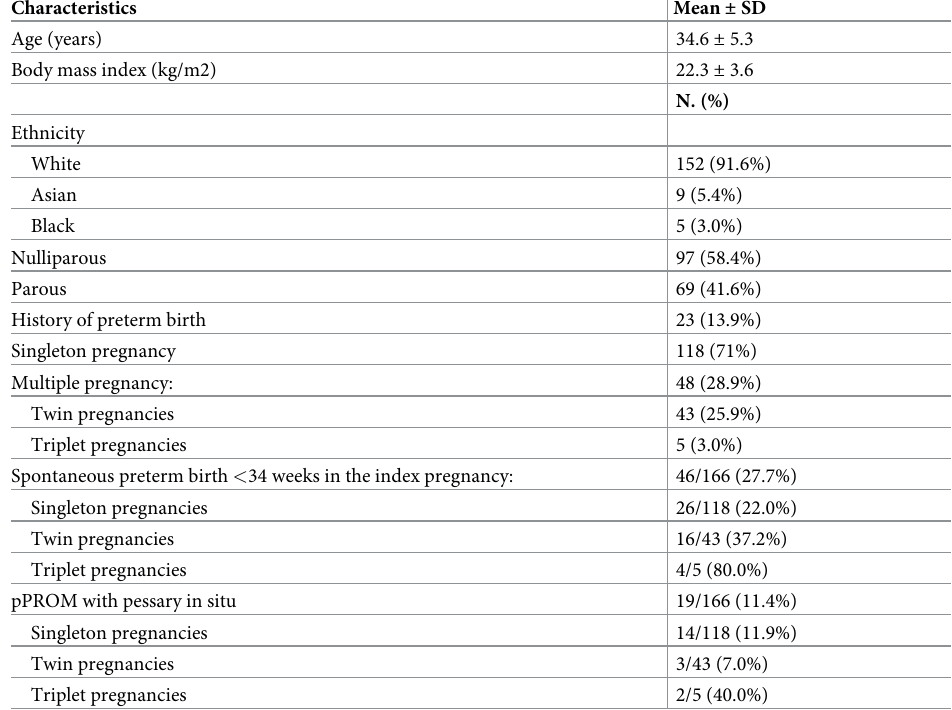
Table 1. Mean characteristics of the study group of 166 women treated with the cervical pessary during an obser- vation period of 10